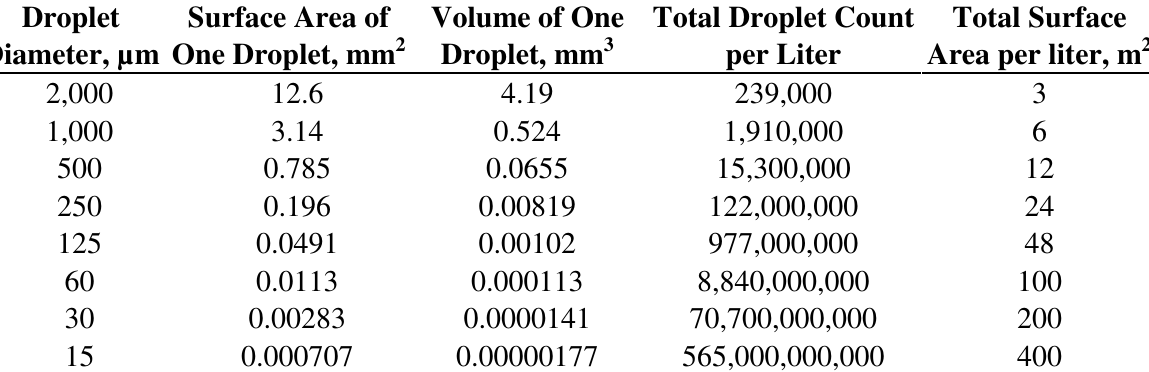
Table 1. Relationships of volume and surface area for various droplet diameters [15].